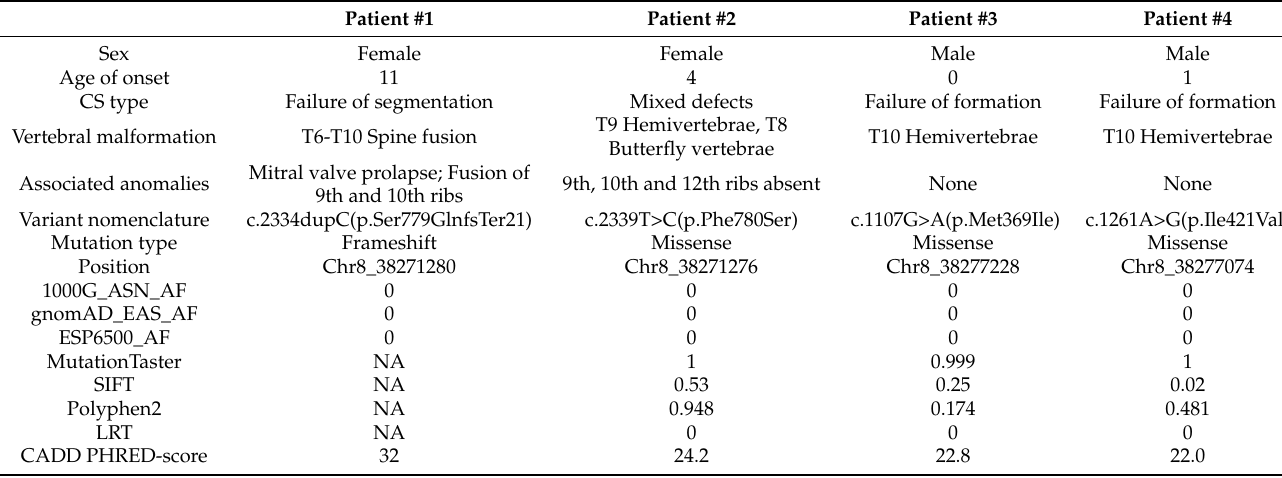
Table 1. Demographic, phenotypic and variant information of four patients in our series. All variants’ nomenclatures were based on the FGFR1 transcript NM_023110.2. All positions were aligned to GRCh37/hg19. Patient